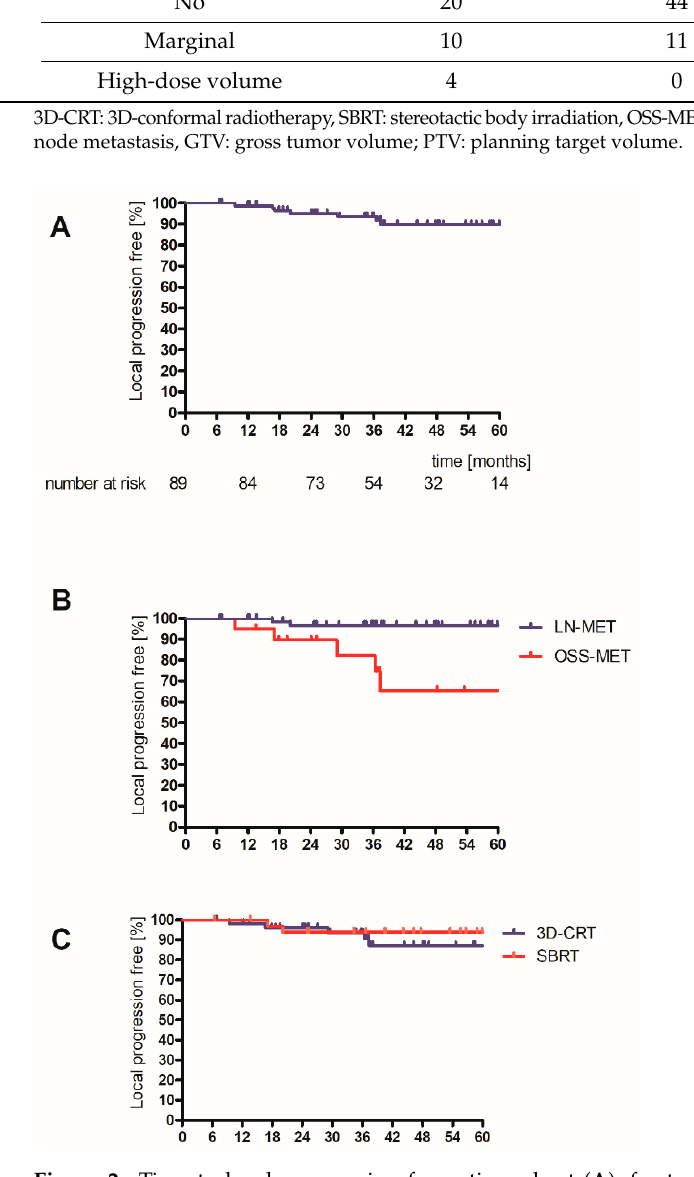
Figure 2. Time to local progression for entire cohort ( A ), for type of MET ( B ), and for SBRT or 3D-CRT ( C ). Log-rank: type of lesion: p < 0.001; treatment schedule p = 0.55. OSS-MET: osseous metastasis, LN-MET: lymph node metastasis, 3D-CRT: 3D-conformal radiotherapy, SBRT: stereotactic body irradiation.